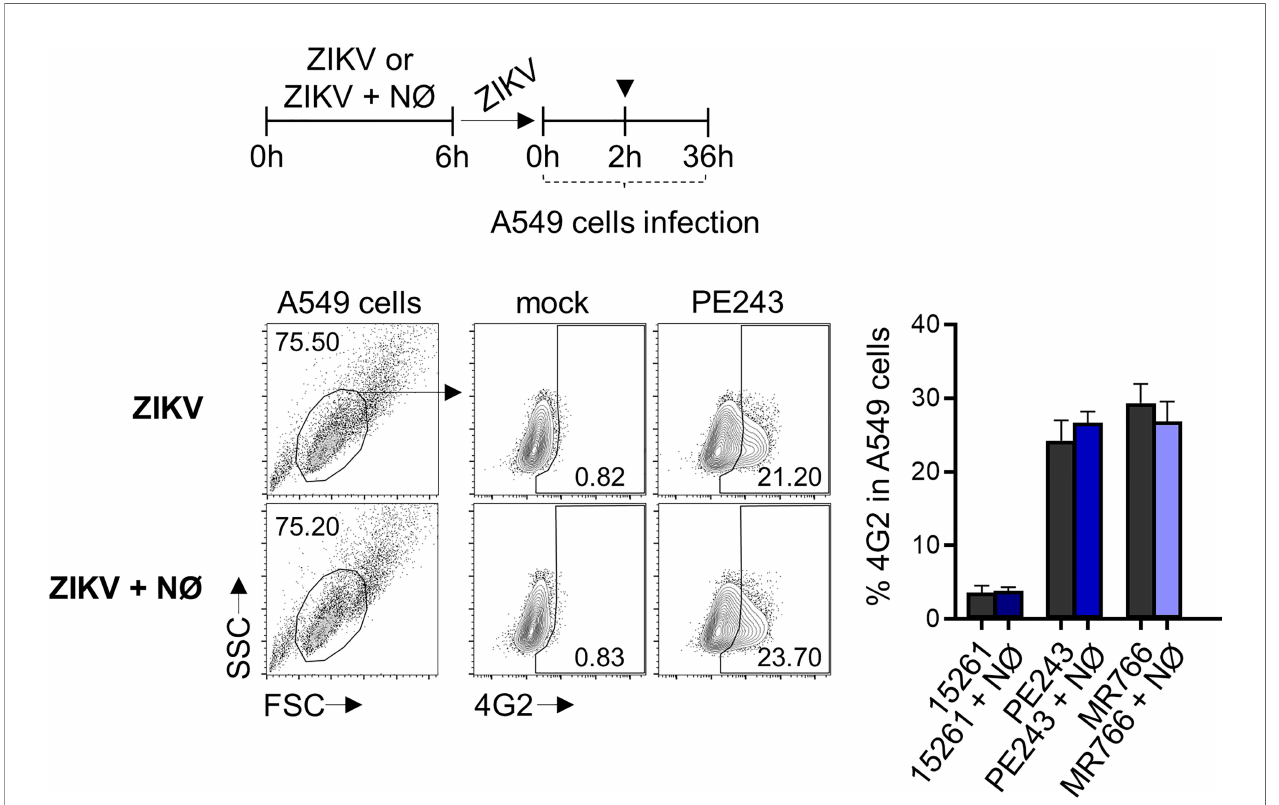
FIGURE 4 | Human neutrophil does not impair ZIKV infectivity. Frequency of 4G2 + A549 cells at 36 hours after infection with ZIKV strains (1 MOI) previously incubated for 6 hours in the absence (ZIKV) or presence (ZIKV + NØ) of neutrophils. ZIKV PE243 is shown as a representative of the ZIKV strains ’ effects on the fl ow cytometry plots. The mock condition was used as a negative fl uorescence control. Bars indicate SEM. Three independent experiments are shown (n = 9). ( ▼ ) indicates the moment A549 cells were washed to remove the virus. NØ, neutrophils.